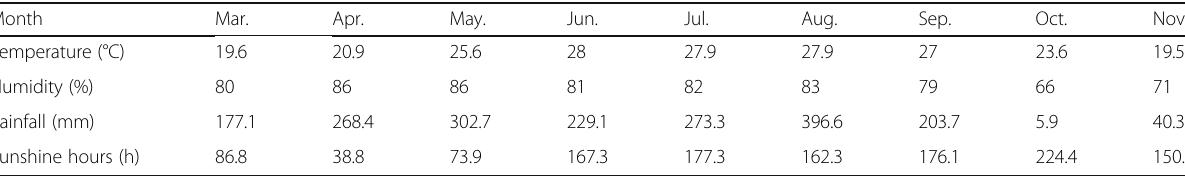
Table 1 meteorological data of the experimental